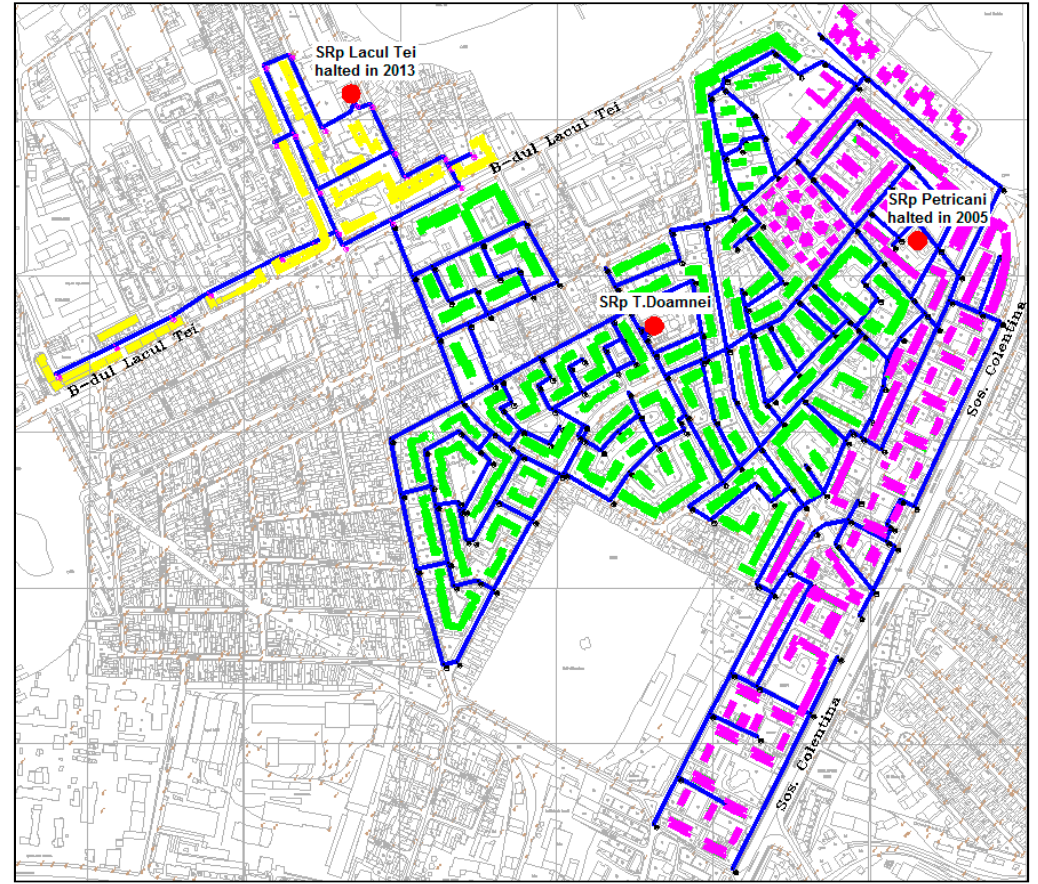
Figure 4. Localization of the initial three pumping stations and their supply areas in Tei-Colentina